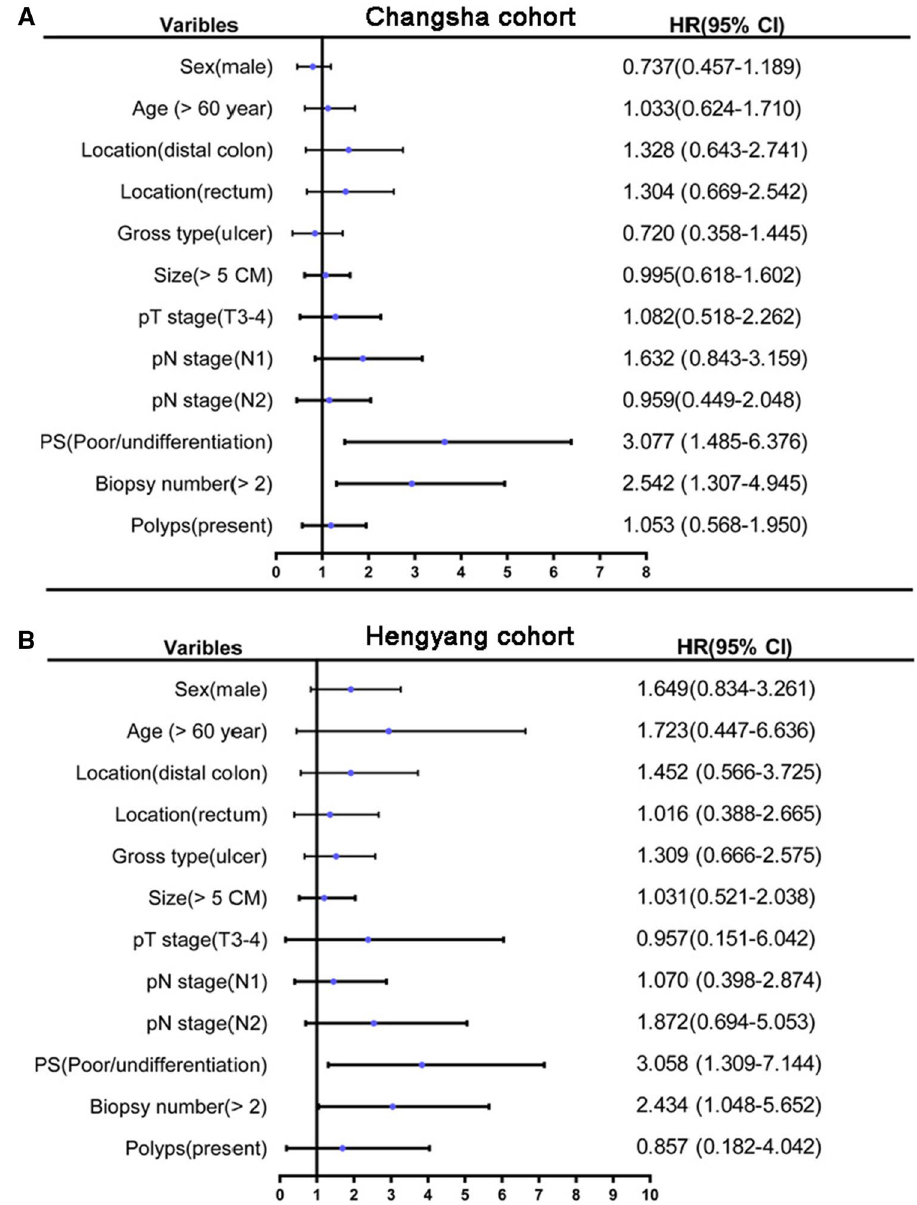
Fig. 2 The forest plots of the influencing factors for the diagnosis of MAC with endos- copy biopsy. A The Changsha cohort showed lower tumor differentiationand more EB numberwere associated with an increased diagnosis probability; B the Hengyang cohort showed the similar